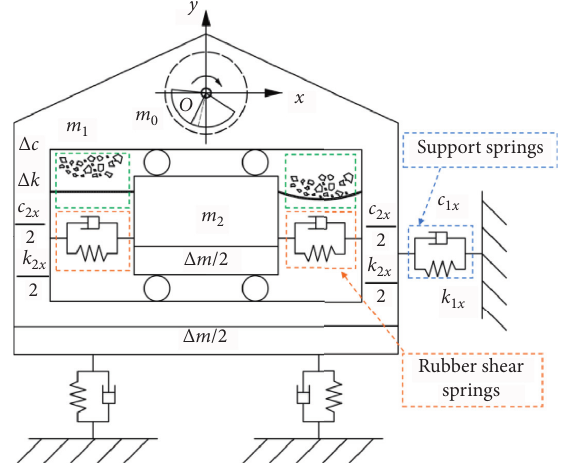
Figure 5: The dynamic model of